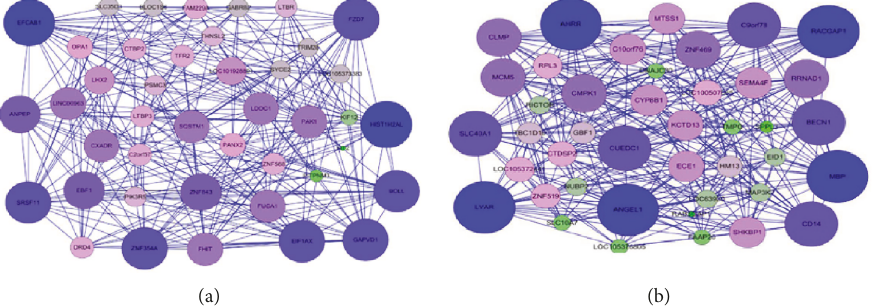
Figure 2: (a) LMG-regulated network. (b) HMG-regulated network. In these two networks, the node with a larger size and deeper color indicates a gene with a higher degree.